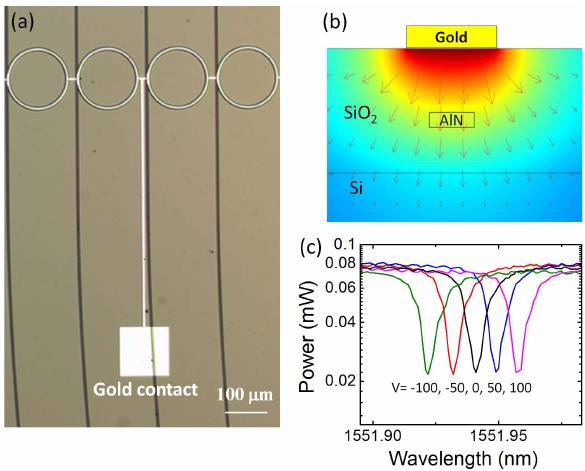
Figure 12: (a) The top view of fabricated device for fast comb on/off switching. (b) The simulated result of the electric field (red arrows) and electric potential (color map) at the AlN waveguide. (c) Experi- mental result of the resonance shift when DC voltage is applied to the electrode from − 100 to 100 V. AlN: aluminum nitride.